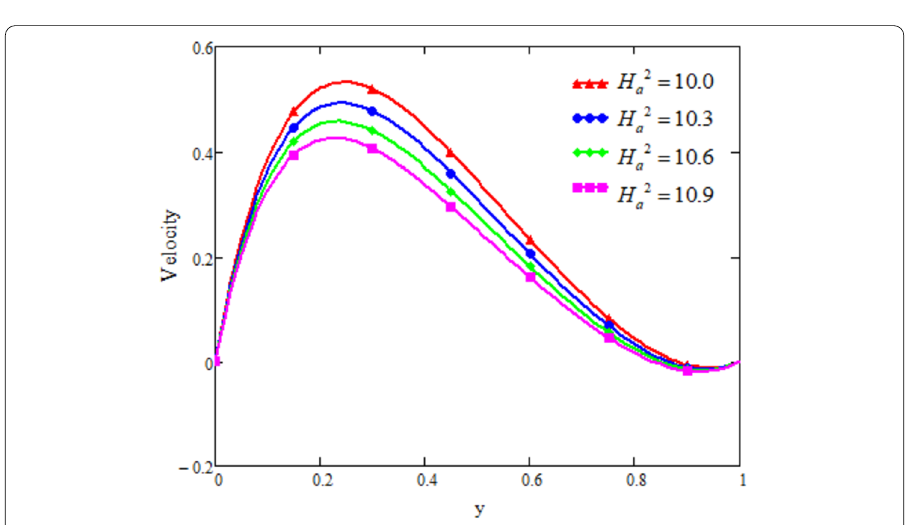
Figure 9 Velocity curves along H a variation and α = 0.5, P r = 11.5, G r = 8, K = 1.5, λ = 0.4, λ 1 = 1.6, t =